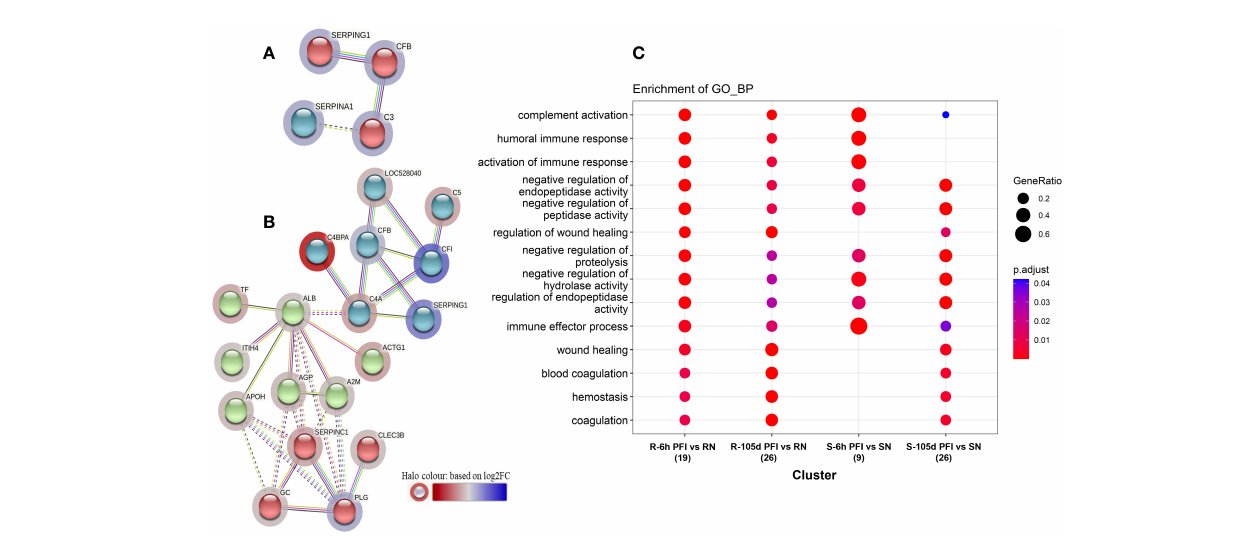
FIGURE 5 Protein-protein interaction networks among differentially abundant proteins in serum samples of tick-susceptible (A) and resistant cattle (B) in response to early tick infestation (SN vs S-6h PFI and RN vs R-6h PFI). Each node represents an individual protein. k -mean clusters showing strong interactions are highlighted as “ red ” , “ green ” , and “ cyan blue ” coloured nodes. The halo colour is based on the log 2 FC value of the proteins in the dataset. (C) Functional enrichment analysis of the differentially abundant proteins in serum samples of tick-resistant and susceptible cattle in response to early (6h PFI) and prolonged (105d PFI) tick infestation. Enriched GO Biological Process terms in the differentially abundant proteins from the comparisons: RN vs R-6h PFI and RN vs R-105d PFI; and SN vs S-6h PFI and SN vs S-105d PFI performed by clusterPro fi ler. The dot colour represents the signi fi cance (P-adjusted < 0.05) of the term, and the dot size (GeneRatio) represents the ratio of input genes that are annotated in a